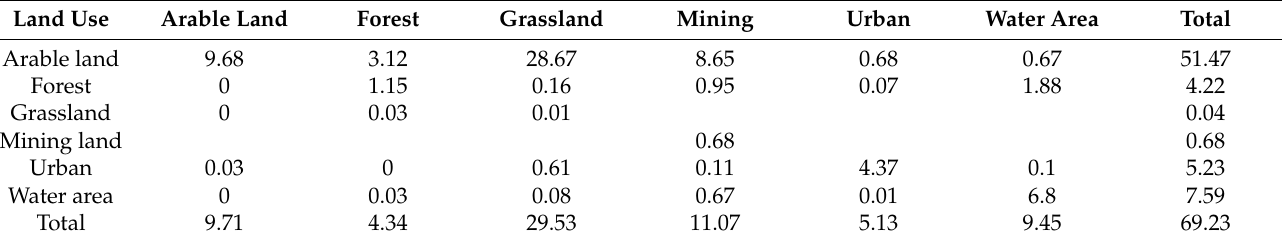
Table 8. Land use transition matrix from post to reclamation (km 2 ).